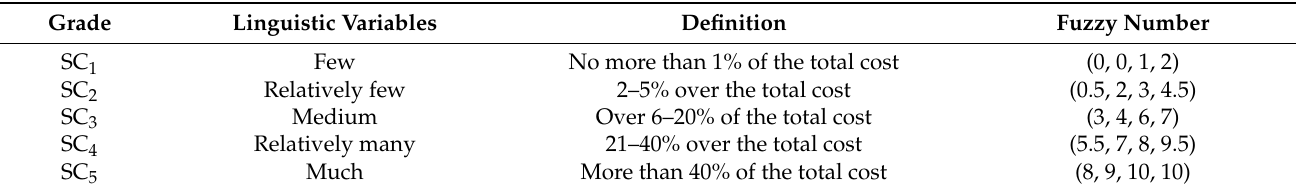
Table 6. Extra cost SC fuzzy rating.